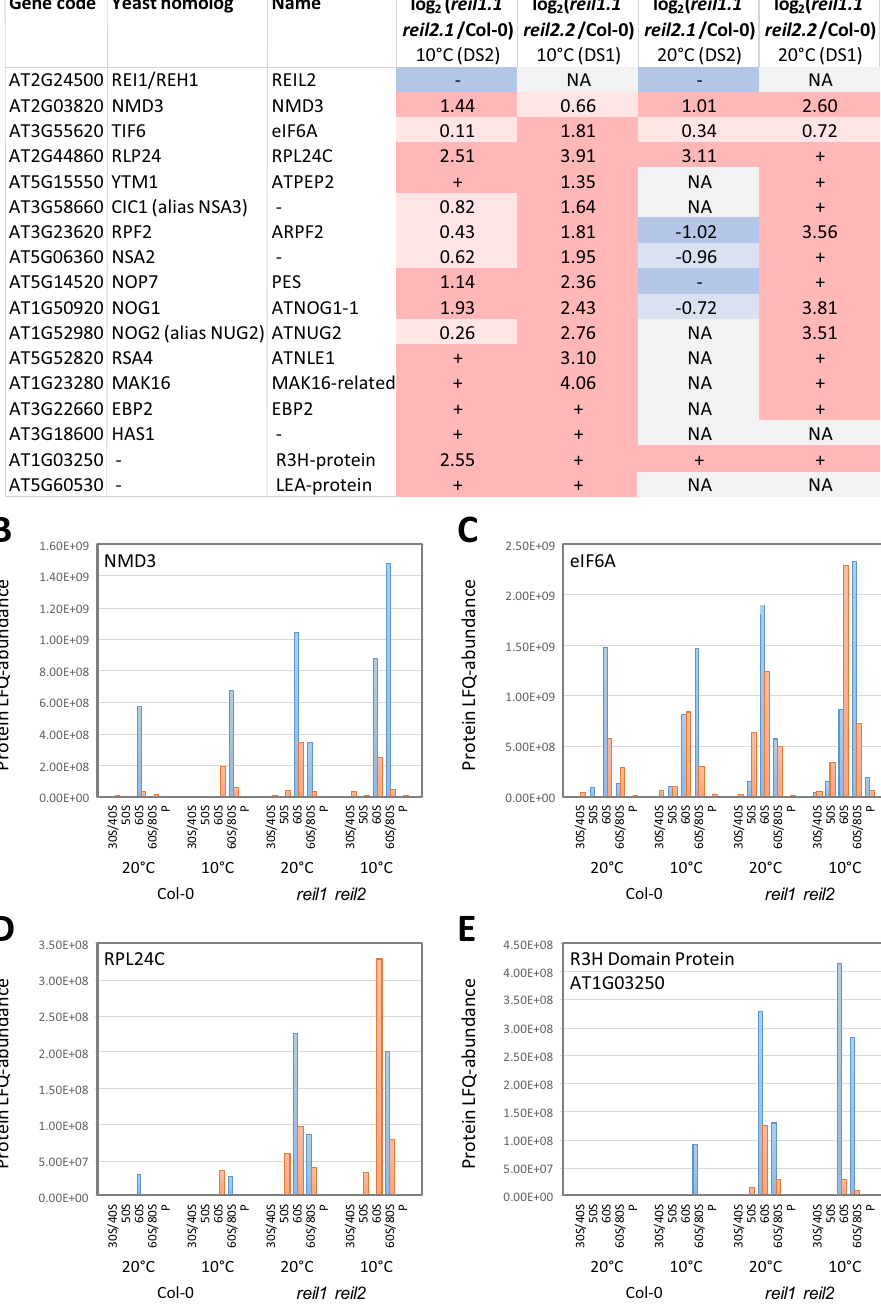
Figure 10. Changes of the composition of ribosome associated proteins in the non-translating 60S fractions of the reil1 reil2 double mutants 7 days after shift to 10 °C and prior to cold shift at 20 °C. ( A ) REIL2 and the shared changes at 10 °C between reil1-1 reil2-1 (DS2) and reil1-1 reil2-2 (DS1). Log 2 -fold changes between mutants and Col-0 wild type are calculated after normalization of protein LFQ-abundances by abundance sums of all detected 60S RPs and combined across the 60S and 60S/80S fractions. Presence in mutants relative to absence in Col-0 and log 2 -fold increases > 1 are color-coded red, increases < 1 are light red. Absence relative to presence in Col-0 and log 2 -fold decreases < − 1 are color-coded blue, decreases > − 1 are light-blue. Absence in both mutant and Col-0 is color-coded grey and indicated by NA (not available). ( B – E ) LFQ-abundance distributions of NMD3, eIF6A, RPL24C, and R3H domain Protein AT1G03250 across the sampled ribosome fractions and analyzed conditions (Experiment DS1, orange; experiment DS2, blue). Note the abundance maxima of the proteins in the non-translating 60S and 60/80S